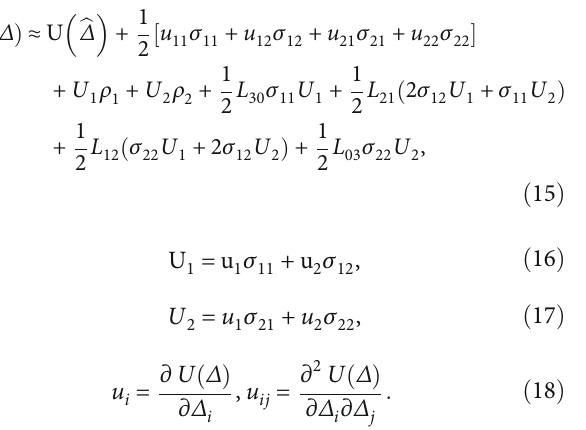
Figure 4: Goodness of fi t curve of the IRE distribution with competitive